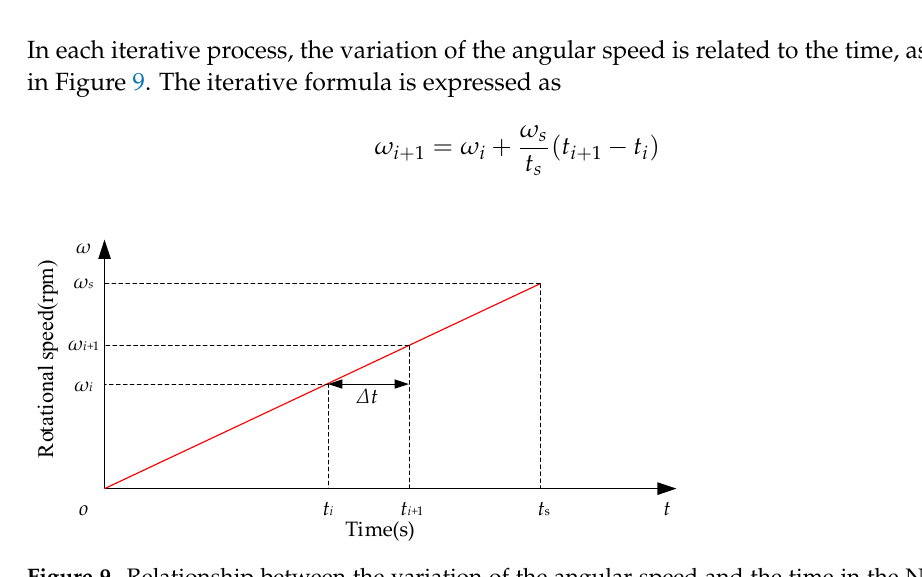
Figure 9. Relationship between the variation of the angular speed and the time in the Newmark method.